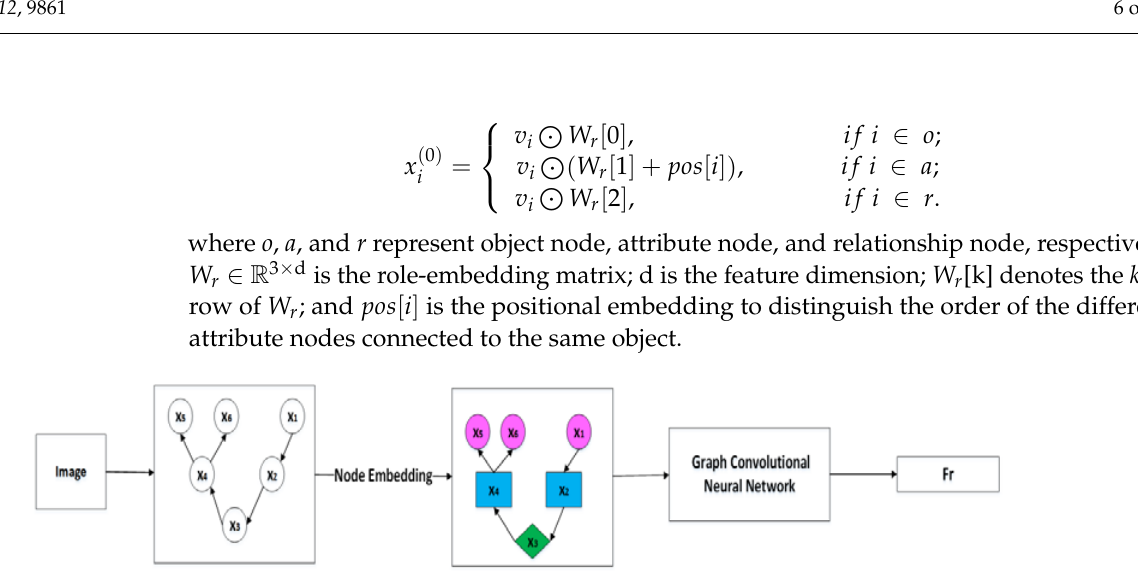
Figure 3. Node embedding (NE) module.